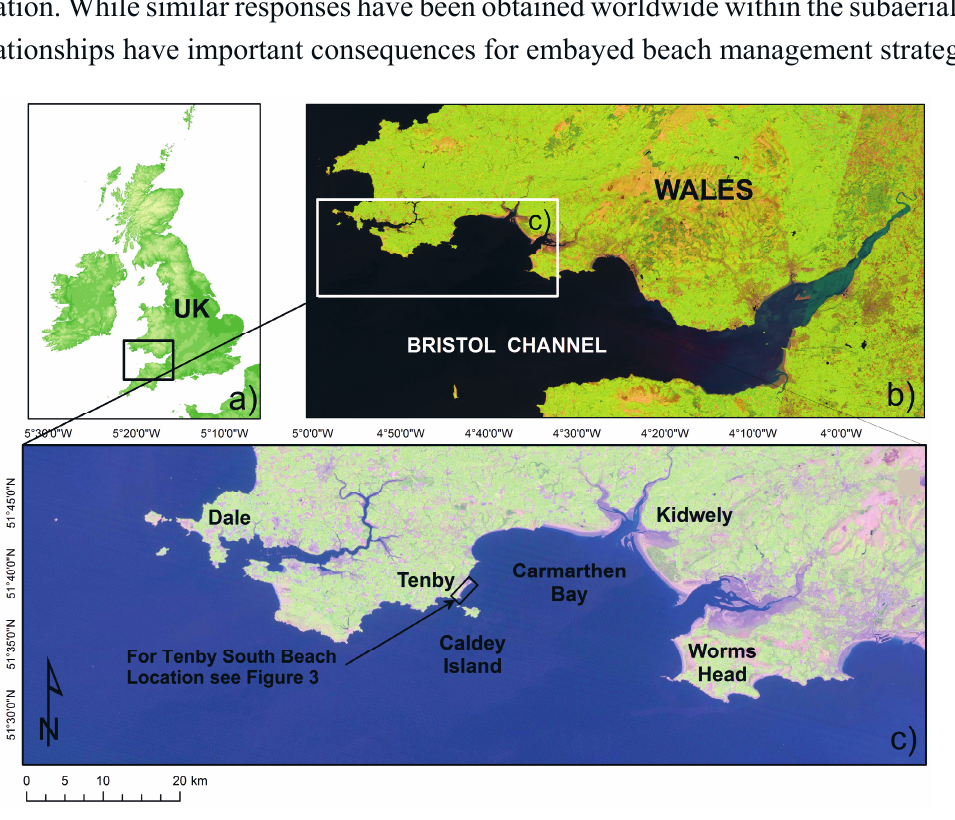
Figure 1. Locality of the study area: ( a ) United Kingdom; ( b ) Bristol Channel; ( c ) Carmarthen